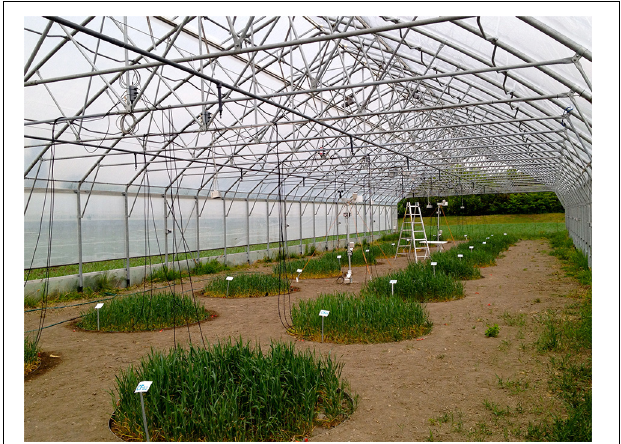
FIGURE 1 | Experimental winter wheat plots containing three different soil types (calcaric phaeozem, calcic chernozem, gleyic phaeozem) subjected to long-time current prognosticated rainfall variations according to regionalized climate change